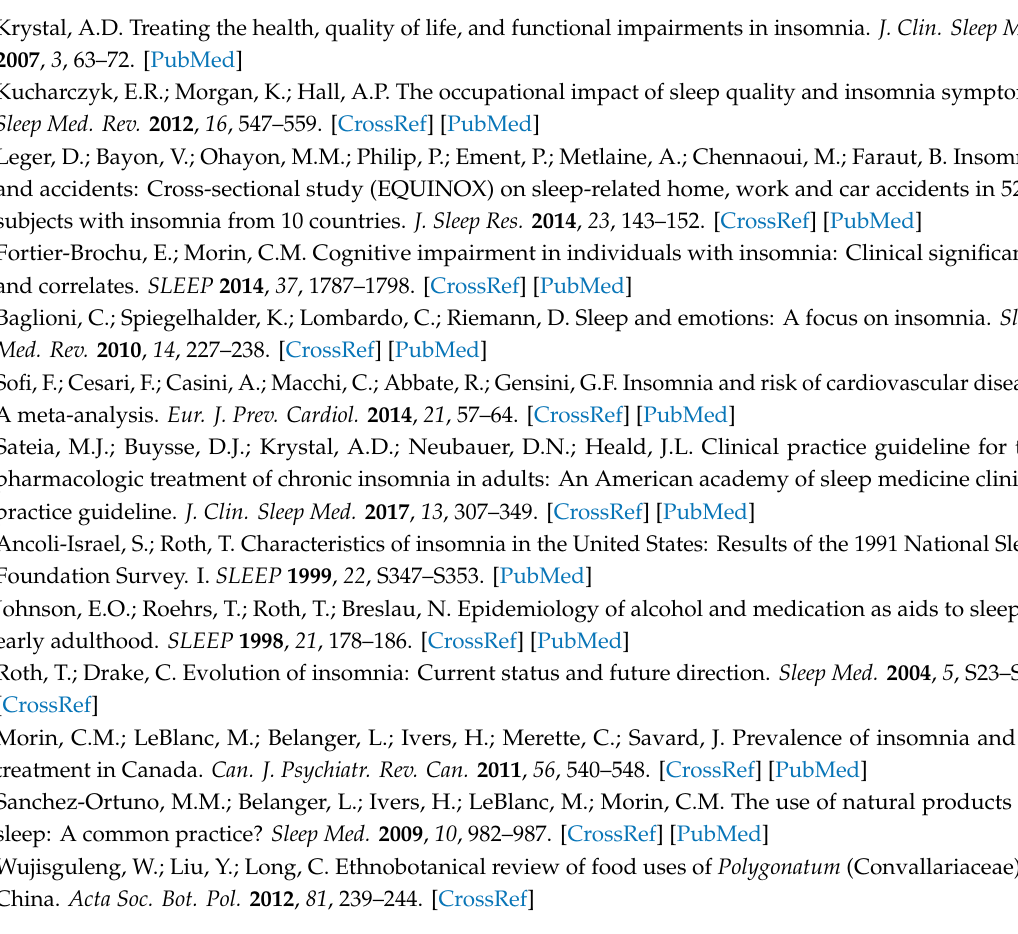
Table S1: Nutritional Value of Polygonatum sibiricum Extract; Table S2: List of ingredients per each Polygonatum sibiricum tablet; Table S3: Cluster information of di ff erences in changes of perfusion between Placebo and PS groups; Table S4: Laboratory data of serum as safety measures; Figure S1: ROI mask for default mode network in the current